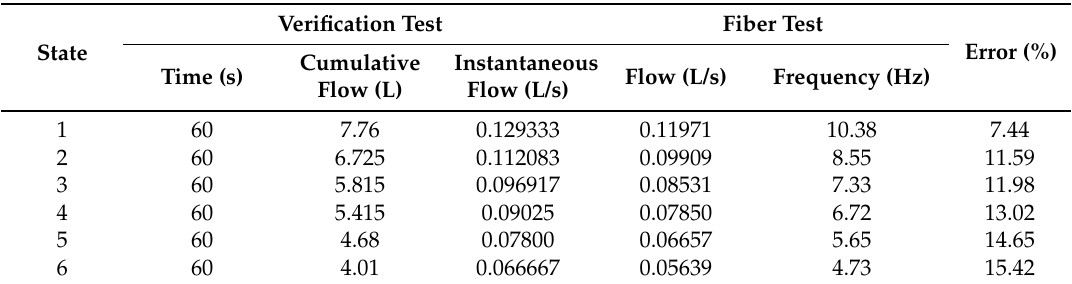
Table 6. Calibration test for fiber flow measurement in the nonlinear range.